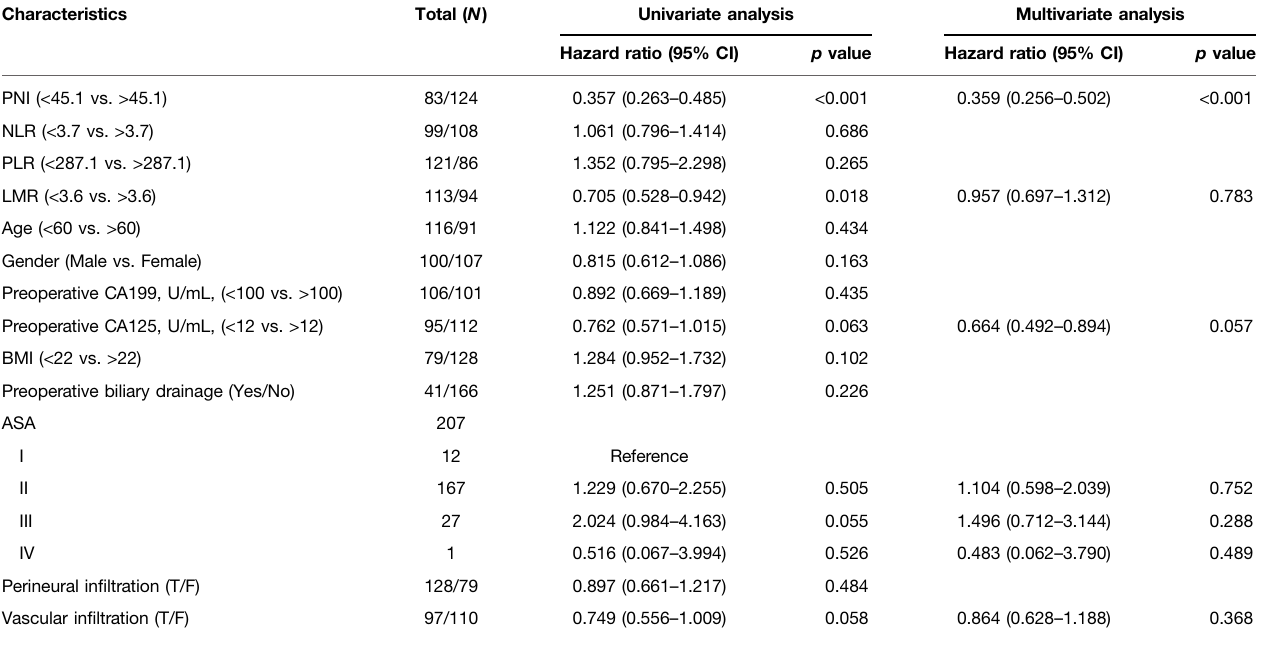
TABLE 2 | PNI and overall survival in pancreatic head carcinoma patients: univariate and multivariate Cox regression analysis. Characteristics